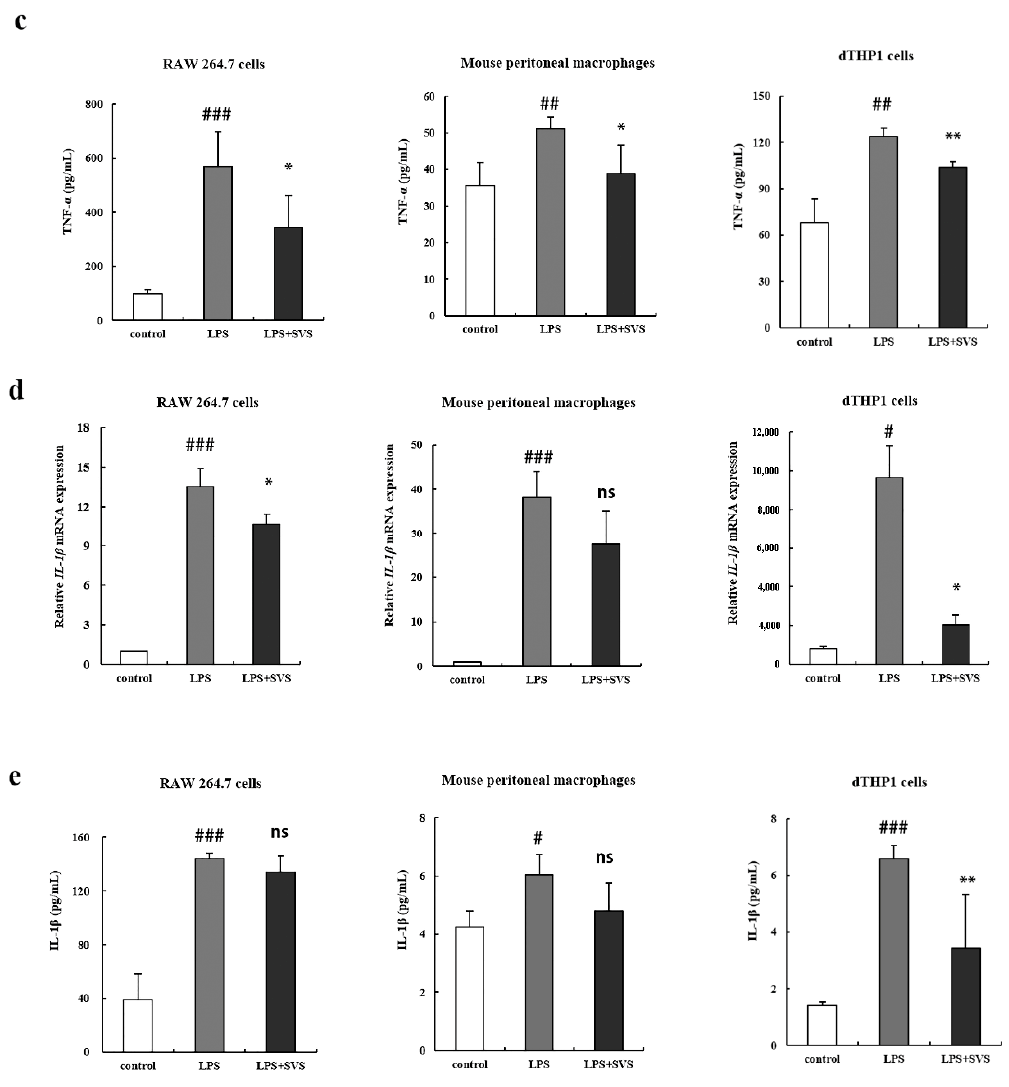
Figure 2. Stevioside reduced production of TNF- α and IL-1 β in LPS-stimulated macrophages. ( a ) Transcripts of TNF- α and IL-1 β was examined by RT-PCR in macrophages pretreated with or without stevioside at the indicated concentrations followed by LPS (1 µ g/mL) stimulation for 9 h. GAPDH was used as an internal control; ( b , d ) mRNA levels of TNF- α and IL-1 β were quantified by RT-qPCR in macrophages pretreated with or without 100 µ g/mL stevioside followed by LPS (1 μ g/mL) stimulation for 9 h; ( c , e ) Protein levels of TNF- α and IL-1 β were detected by ELISA in the supernatant of macrophages with stevioside (100 μ g/mL) pretreatment for 1 h and LPS (1 μ g/mL) stimulation for another 24 h. Experiments were repeated three times. # p < 0.05, ## p < 0.01, ### p < 0.001 versus control group; * p < 0.05; ** p < 0.01 versus LPS-treated group; ns, no significant difference versus LPS-treated group. SVS, stevioside.